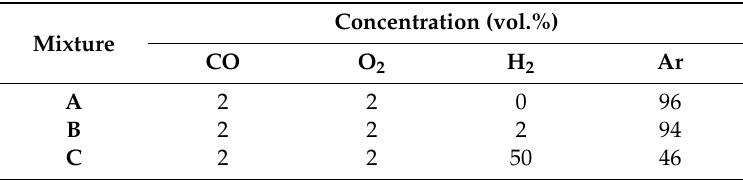
Figure 4. Schematic representation of the ligand-assisted pinning mechanism of Au cores for the different generations of dendrons after thermal treatments. Table 4. Composition of the inlet